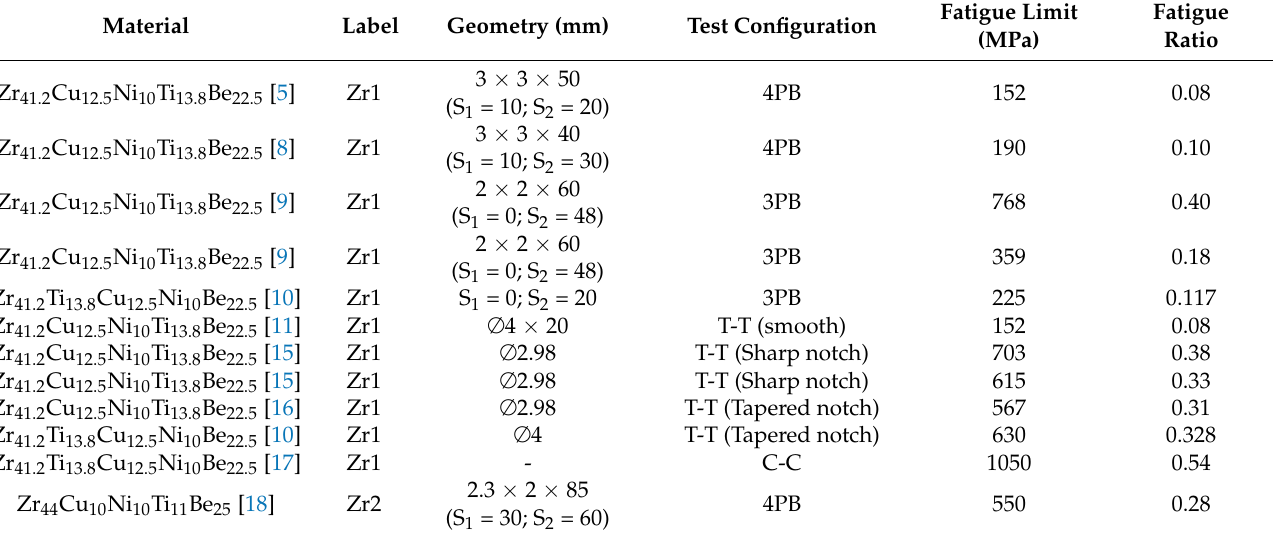
Figure 1. Statistical results of fatigue ratio in various metallic glasses (MGs) tested under different loading including four-point bending (4PB), three-point bending (3PB), tension–tension (T-T) and compression–compression (C-C) fatigue loading. The fatigue ratios are termed as the fatigue endurance limit divided by the fracture strength. The data for this figure were listed in Table 1. Table 1. Summary of fatigue limits and ratios under varying fatigue loading modes in different MGs based on the literature reports [5–30].